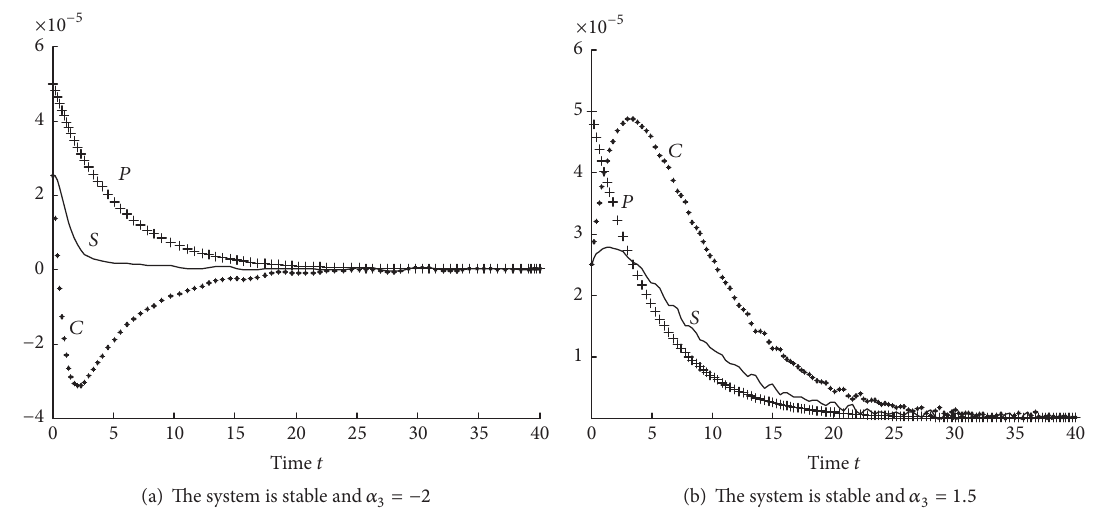
Figure 2: Variation trends of parameters and resource elements under the influence of resource